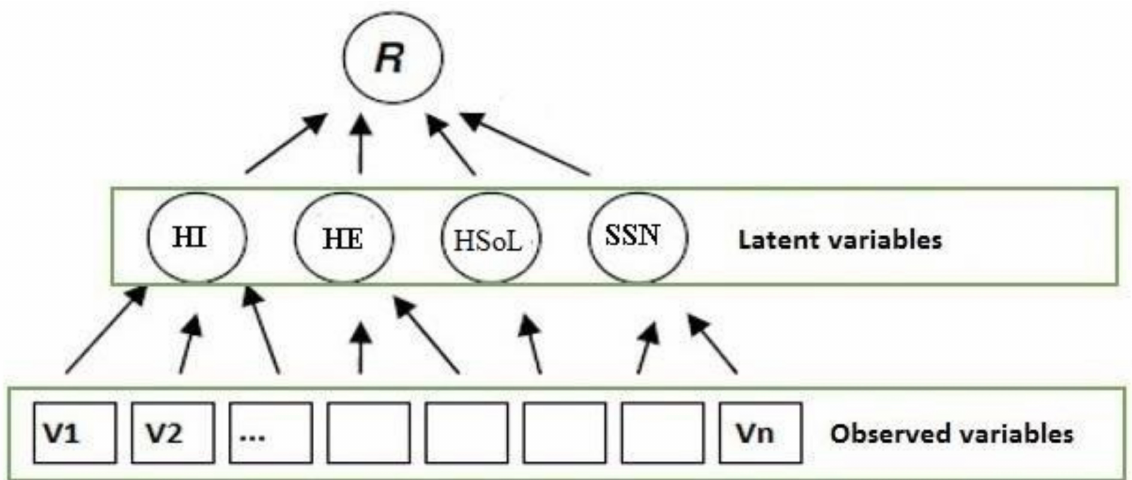
Figure 2. Path diagram of the household disaster resilience composite index Source: Adapted by Abdullah Al-Maruf from Alinovi et al. (2010)